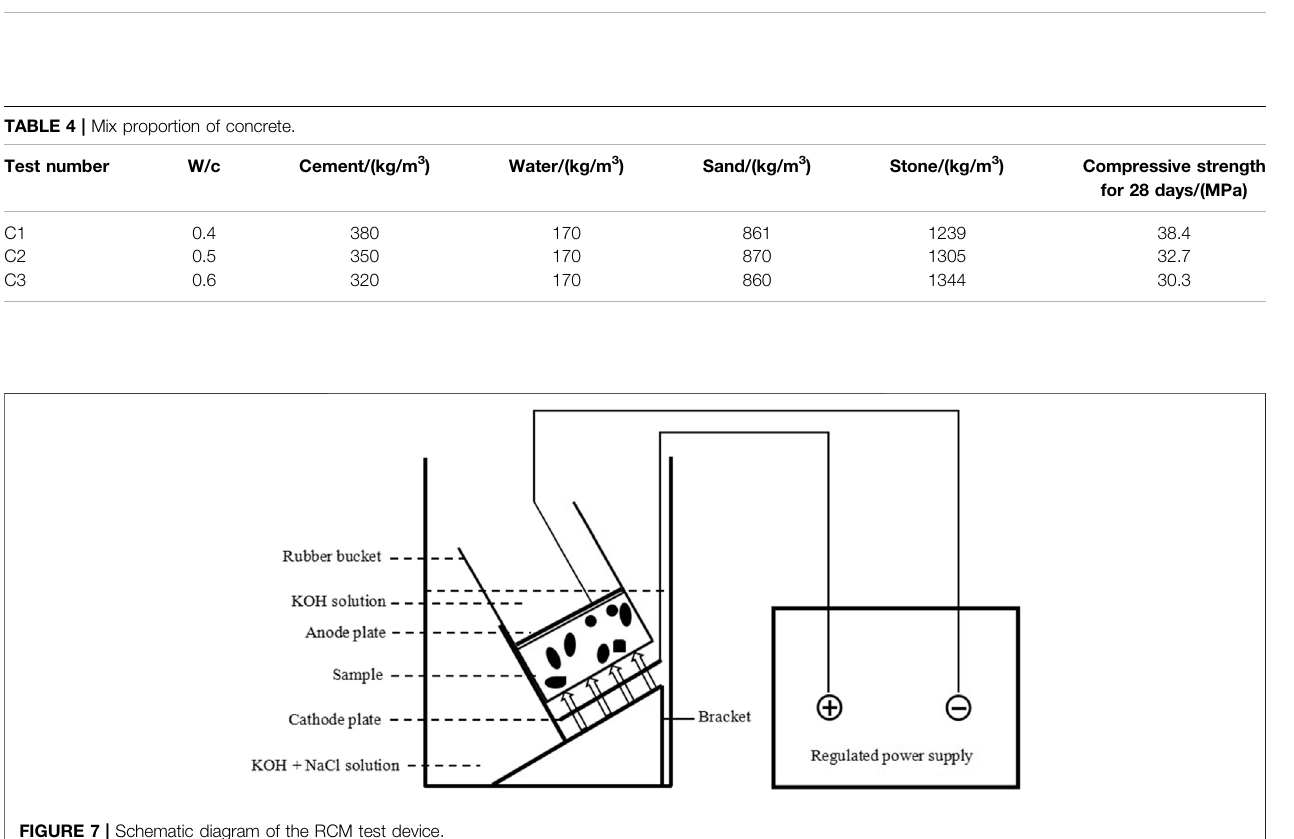
FIGURE 7 | Schematic diagram of the RCM test device.